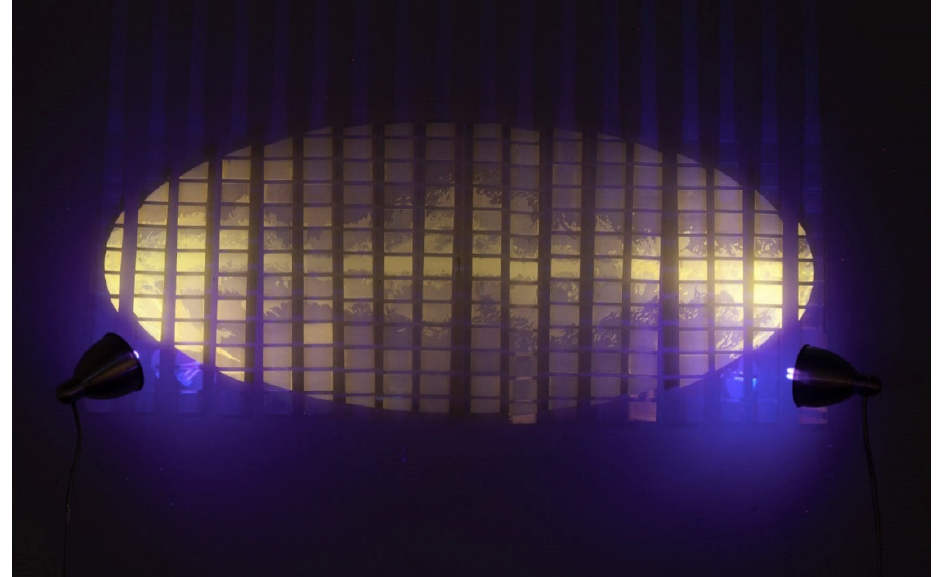
Figure 7. Interstellar Dust in the Milky Way (2018) by Ana Margarida Rocha. Screen print on glass slides, UV light. Installation in the Alberto Sampaio Museum, Guimarães, Portugal. Author’s